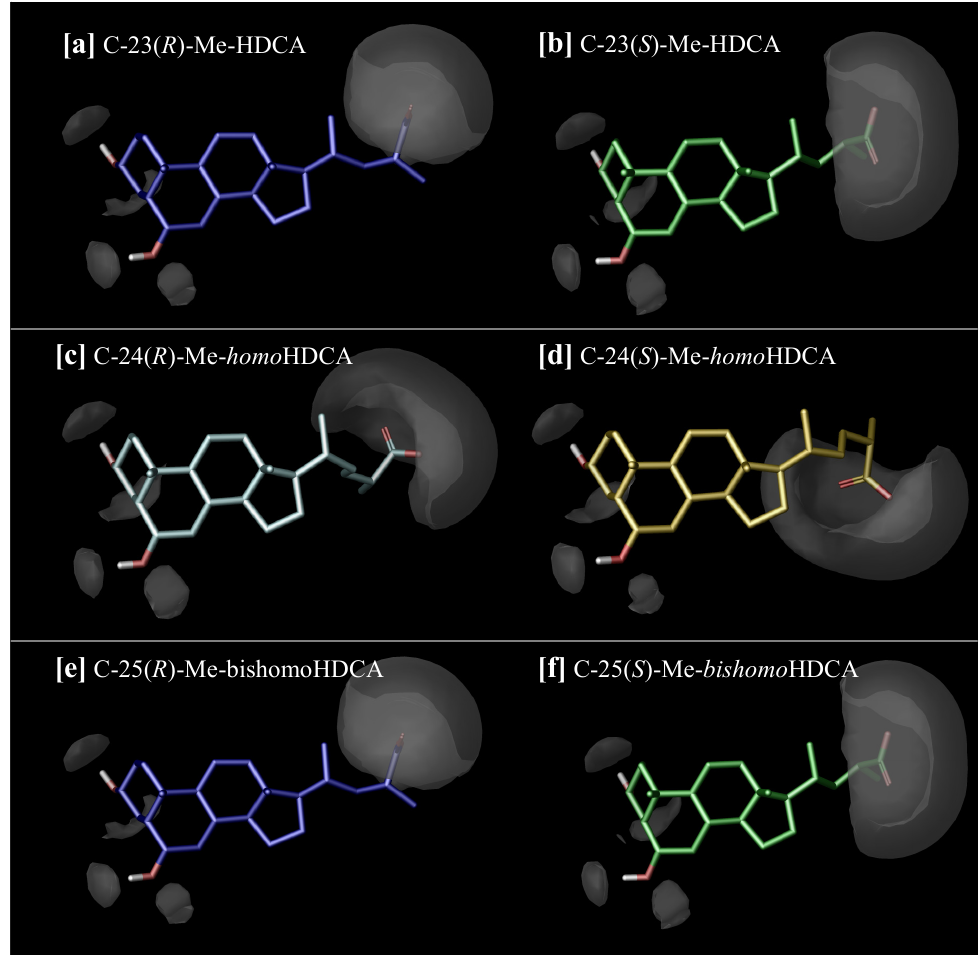
Figure 3. Disposition of the favourable hydrophilic volumes in ( a ) C-23( R )-methyl HDCA ( 5 ); ( b ) C-23( S )-methyl HDCA ( 4 ); ( c ) C-24( R )-methyl homoHDCA ( 7 ); ( d ) C-24( S )-methyl homoHDCA ( 6 );( e ) C-25( R )-methyl bishomoHDCA ( 9 ); ( f ) C-25( S )-methyl bishomoHDCA ( 8